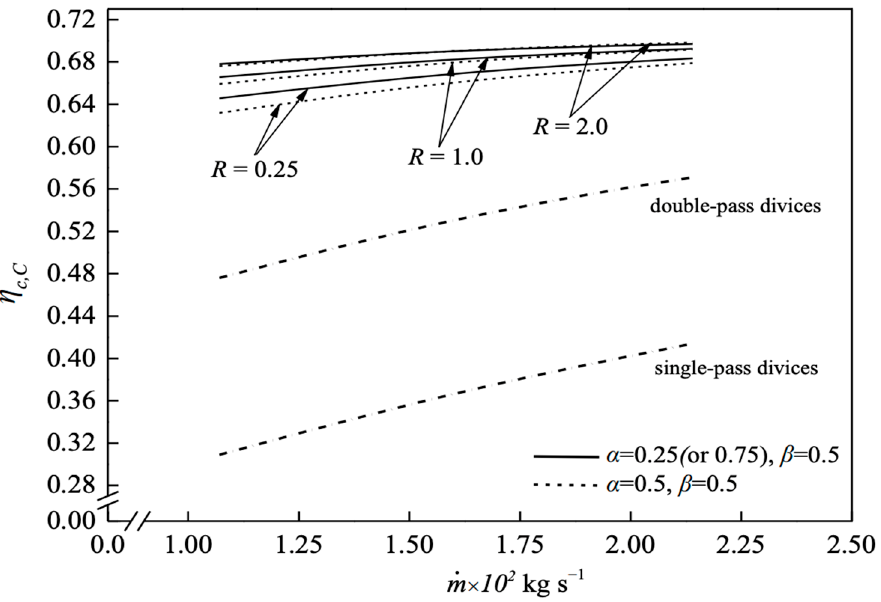
Figure 12. The ratio of the collector efficiency improvement and hydraulic dissipated power con- sumption increment.